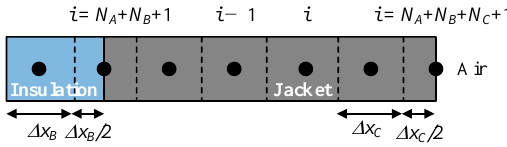
Figure 7. Outer jacket discretization.